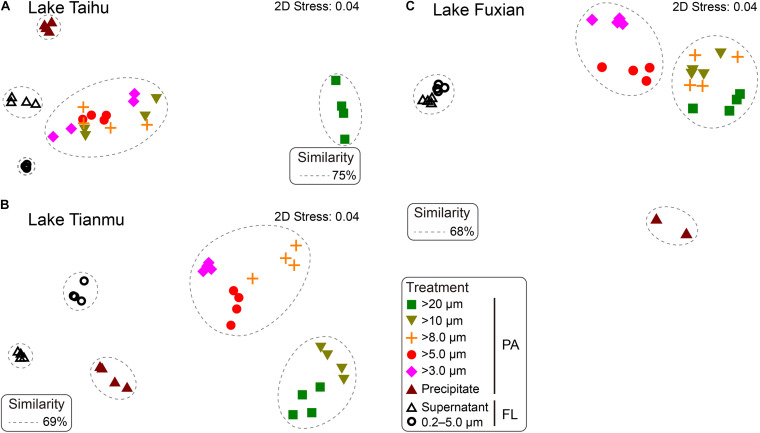
Non-metric multidimensional scaling (nMDS) showing the distance between samples generated from different treatments in (A) Lake Taihu, (B) Lake Tianmu, and (C) Lake Fuxian. Samples with Bray-Curtis similarities of 75% in Lake Taihu, 69% in Lake Tianmu, and 68% in Lake Fuxian, respectively, are circled with dashed lines. PA, particle-attached; FL, free-living.